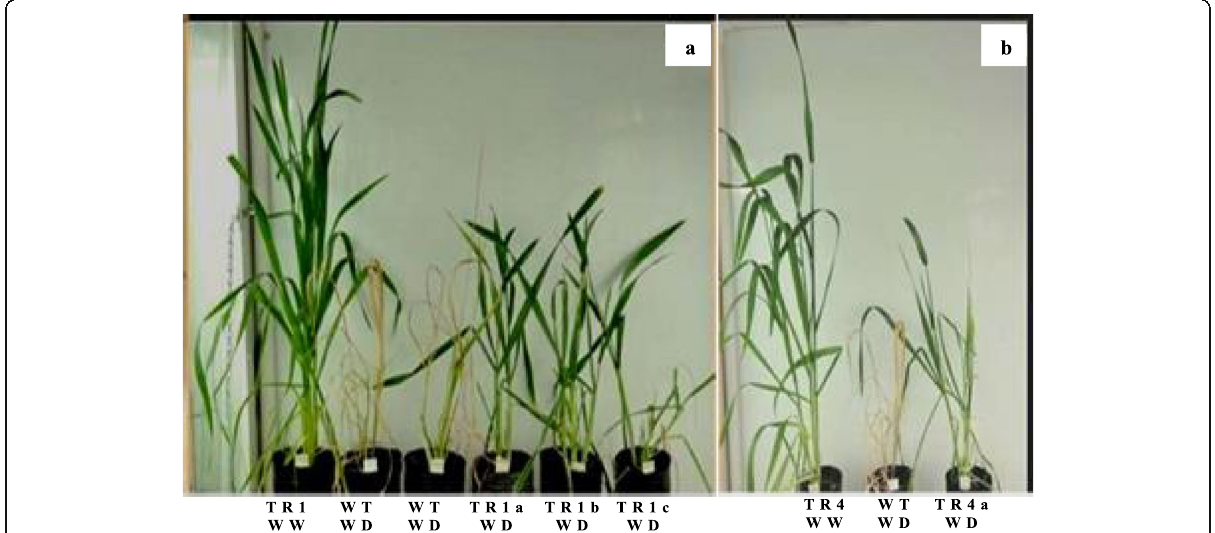
Fig. 3 Transgenic wheat plants under WW and WD conditions. a Plants from TR1. b Plants from TR4. WW: well-watered: WD: